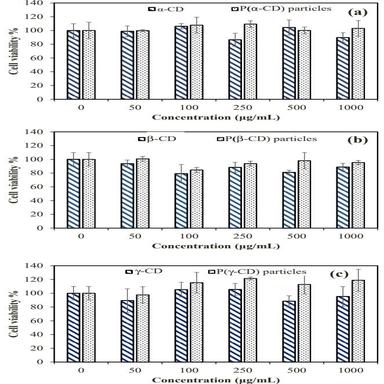
Cytotoxicity of (a) α-CD molecules and p(α-CD) particles, (b) β-CD molecules and p(β-CD) particles, (c) γ-CD molecules and p(γ-CD) particles on L929 fibroblasts at 24 h incubation time.